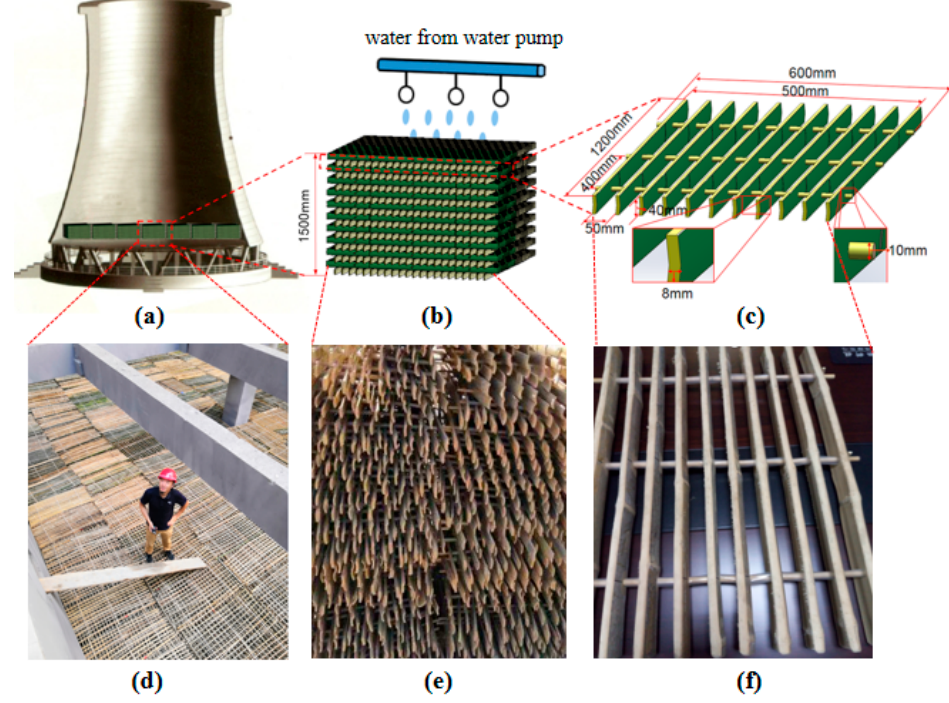
Figure 1. ( a , d ) Application of bamboo grid packing (BGP) in hyperbolic cooling towers; ( b , e ) stack of BGP units; ( c , f ) BGP assembled with bamboo strips.